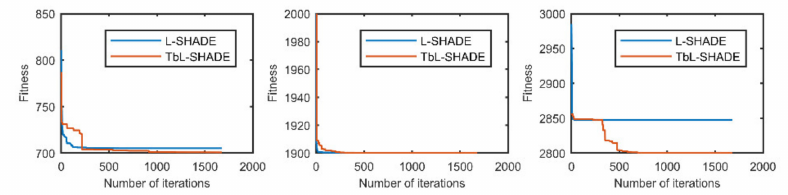
Figure 5. The selected average convergence of L-SHADE and TbL-SHADE is compared on CEC2020 in 5 D . From left to right f3, f4 and f10.